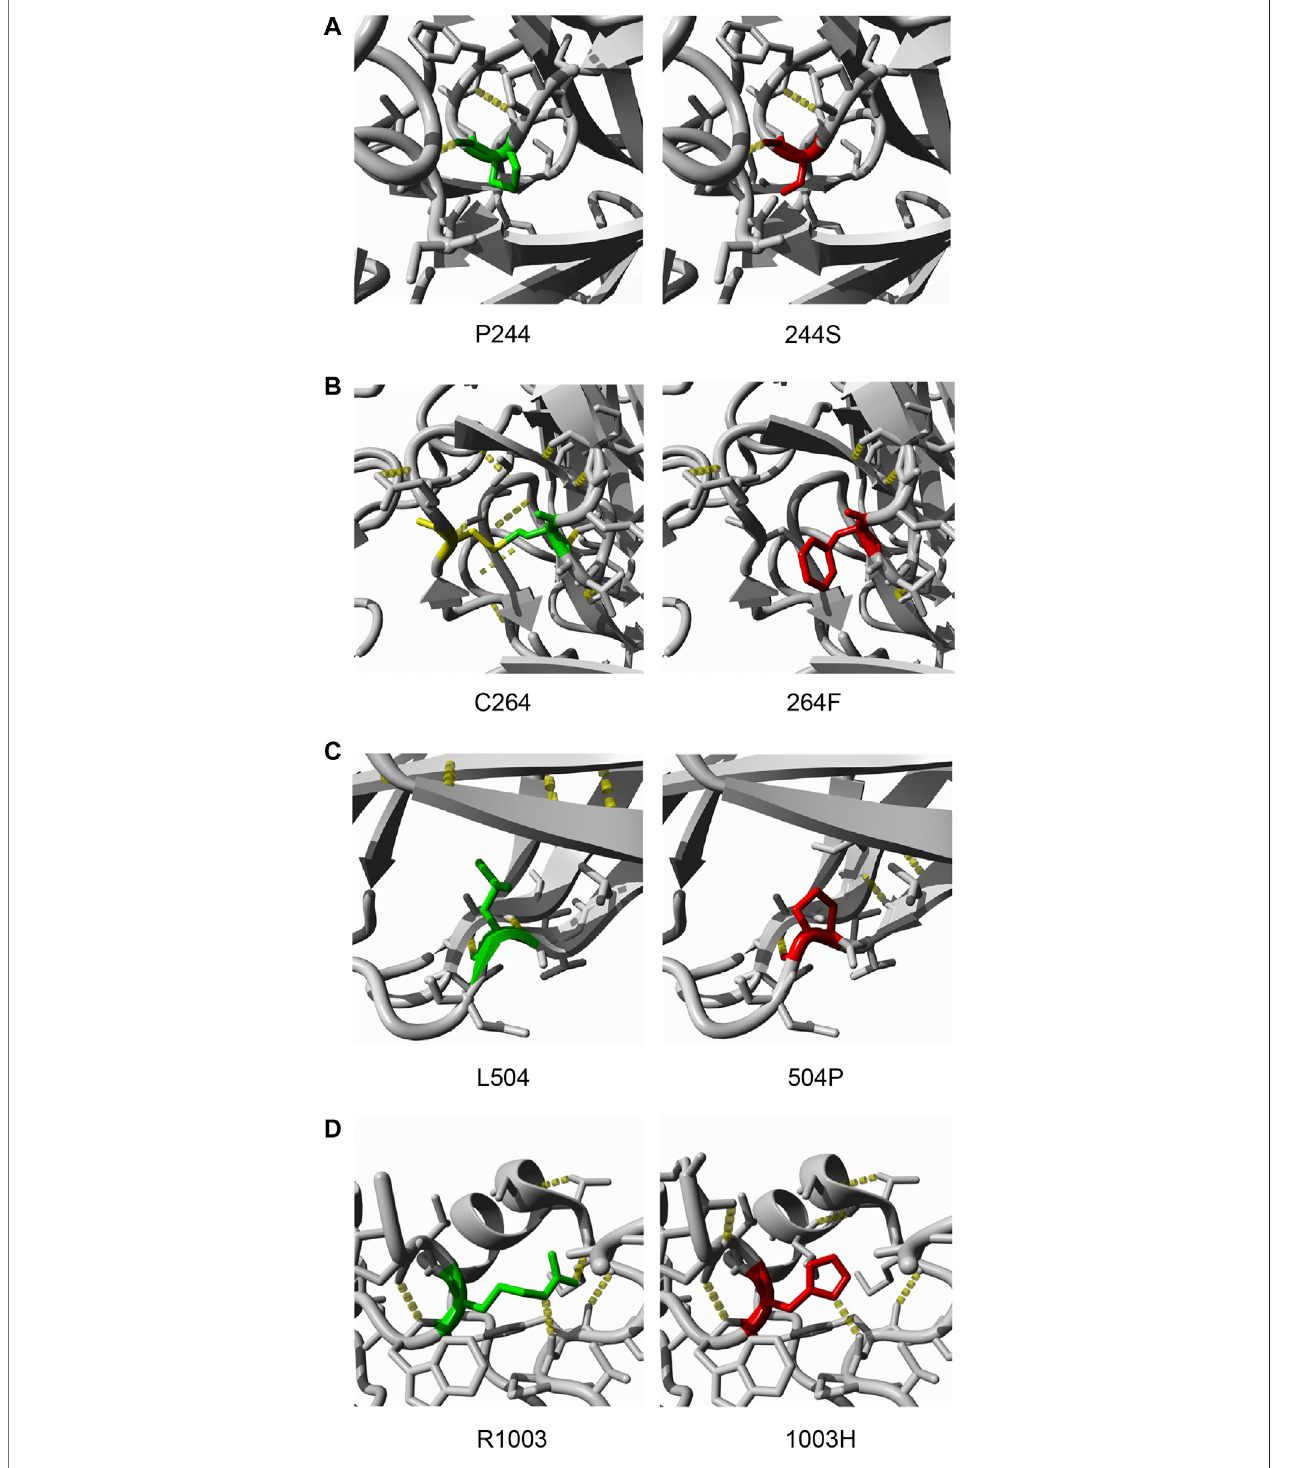
FIGURE 2 | Crystal structures of four pathogenic TEK mutants (A) . p.P244S substitutes a nonpolar proline to polar serine, which may in fl uence the structure of a β -turn (B) . Cysteine-264 forms adisul fi de bond withCysteine-255.Thus, substitution ofC264 waspredicted tobe destabilizing due tothe disruption ofadisul fi de bond (C) . p.L504P is within a β -sheet of the FNIII domain; the substitution is likely to cause loss of hydrogen bonds, as is the case in p.R1003H (D) . Green, wild-type residue; red, mutated residue; yellow, cysteine-255; yellow dots, hydrogen bonds.